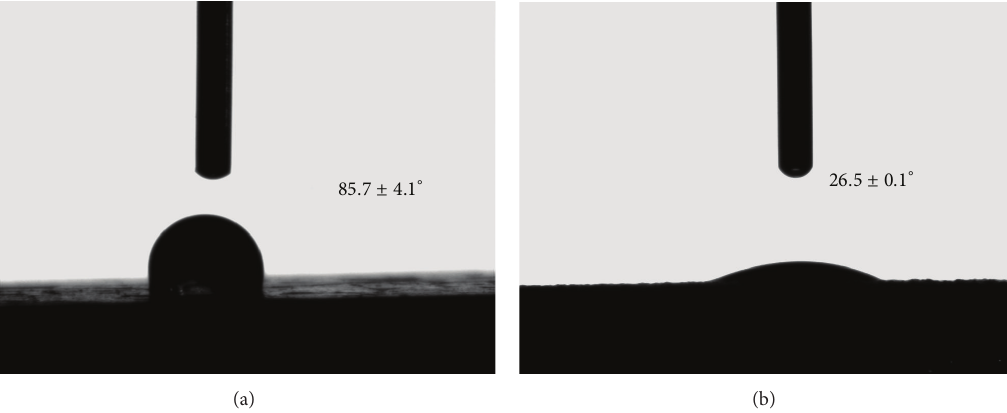
Figure 6: The photos and values of contact angle toward distilled water for (a) uncoated C/C composites and (b) SiC/Ti6Al4V coatings.